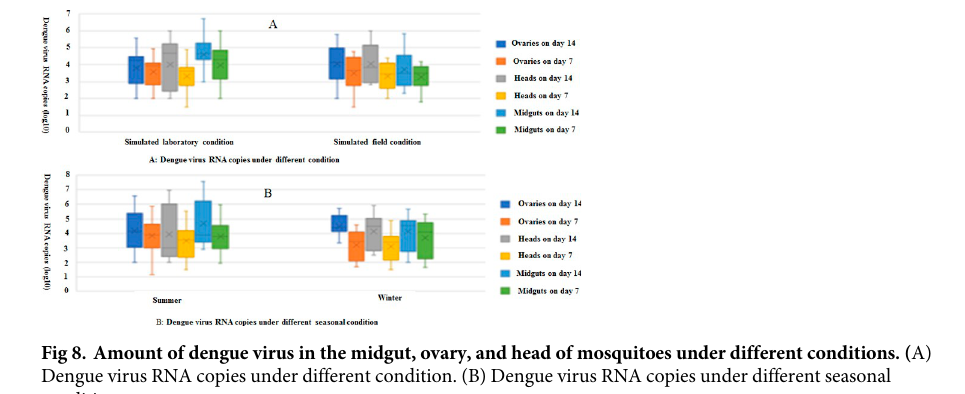
Table 6. There was no significant difference in the RNA copy number of mosquitoes infected with dengue virus in the ovaries, head, and midgut tissues at 7 and 14 dpi (P > 0.05). The results of variance tests showed that the mean copy number of virus RNA in the midgut at 7 dpi in summer was higher than that at 7 dpi in winter (F = 14.459, P = 0.01). The mean copy number of virus RNA in the ovary at 7 dpi in summer was also higher than that at 7 dpi in win- ter (F = 8.656, P < 0.001); however, there was no significant difference in the number of virus copies at other time points (P > 0.05) (Fig 8B, S5 Table).